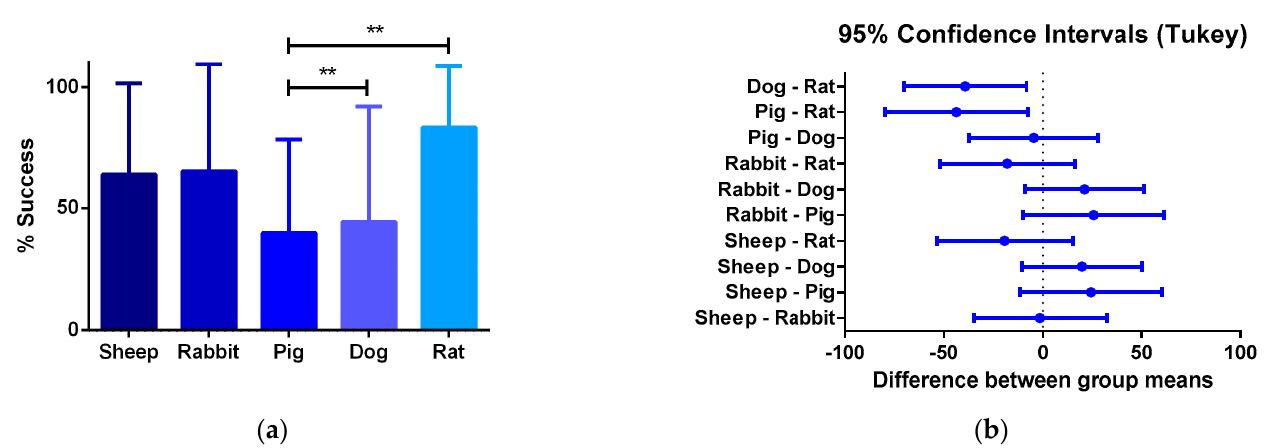
Figure 4. ( a ) One-way ANOVA analysis of different success percentages of preclinical studies in different species: Success is defined by the capacity of the graft to overcome the stabilization of the immune response and start the remodeling process of the vascular wall. From all the specimens participating in pre-clinical trials, the number of individuals participating in the preclinical studies and the percentage of the total of individuals from each species that is successful are compared to the others. ( b ) 95% confidence interval Tukey test for the number of vascular grafts that reached phase III between animal models. The quantitative data are expressed as the mean ± SD, where * p ≤ 0.05, ** p ≤ 0.01, *** p ≤ 0.001, **** p ≤ 0.0001 when compared between models.